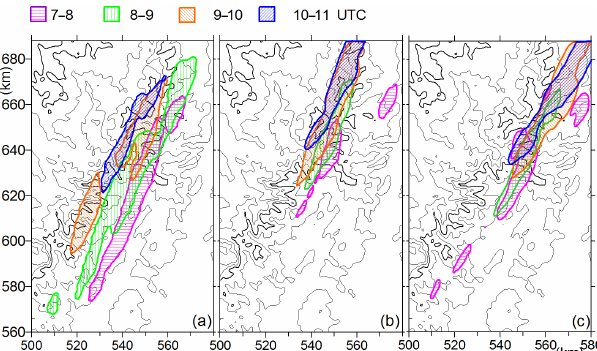
Figure 7. Surface areas with hourly rain>20mm. Results from the KED analysis are presented in (a) , the model results for scenario HymRef in (b) , and those for scenario Remote in (c) .